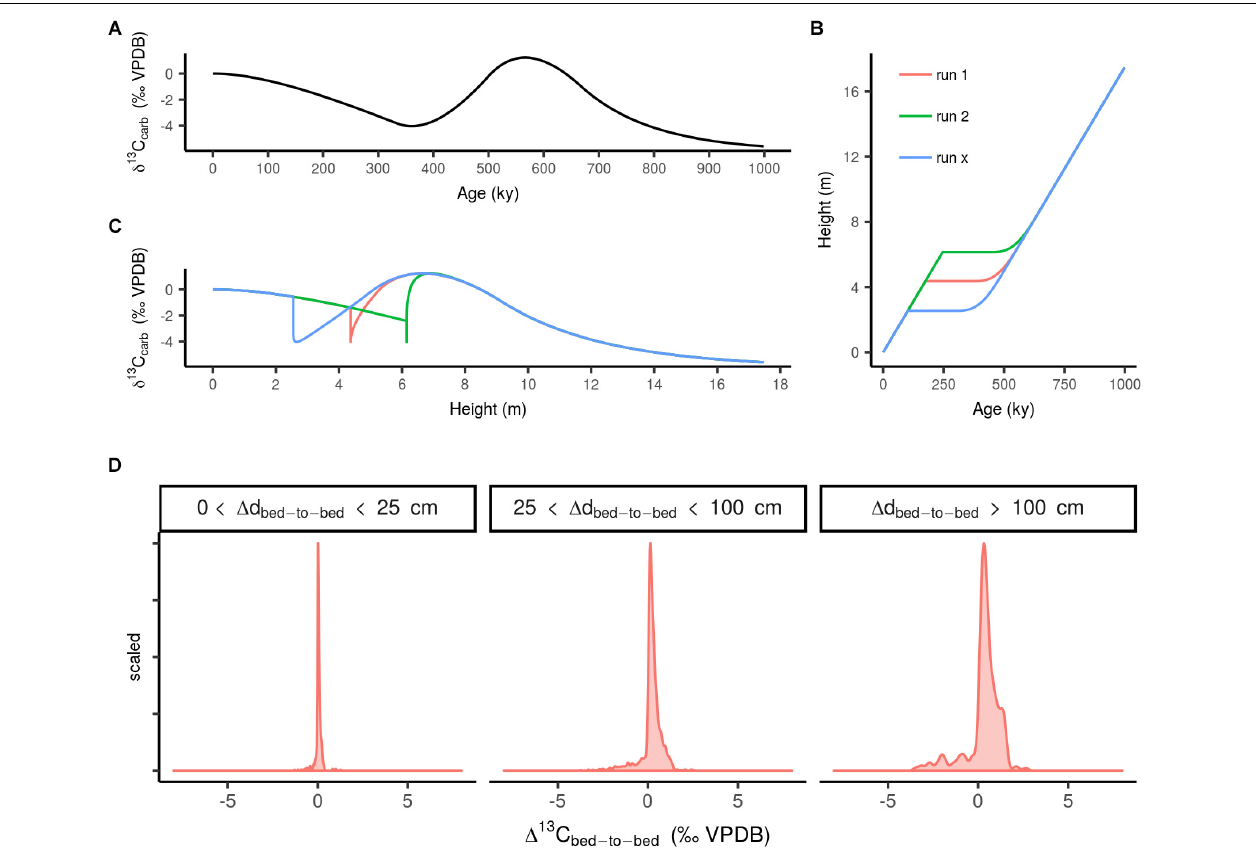
FIGURE 4 | (A) Randomly simulated timeseries of carbon cycle perturbations. (B) Age model for the simulated stratigraphic series with a sedimentary hiatus (with runs to exemplify the different simulations, real number of runs is 30). (C) The same simulated δ 13 C carb sequence but plotted as height and distorted by sedimentary rate changes forced by a third-order sea-level fall and subsequent rise. (D) Scaled frequency distribution of (cid:49) 13 C bed − to − bed variation for multiple simulations of hiatus-distorted stratigraphic δ 13 C carb